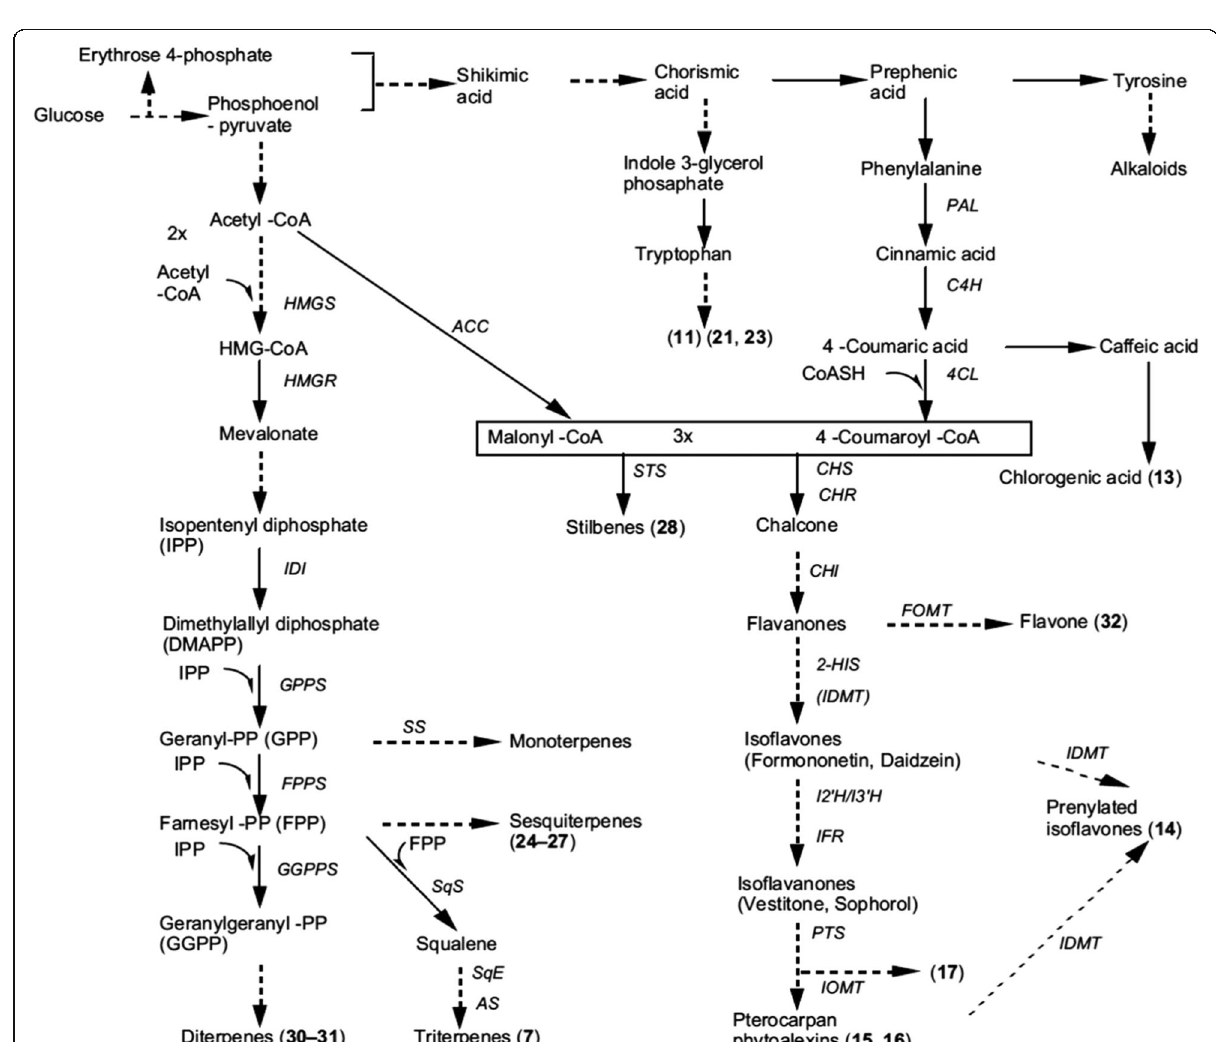
Fig. 1 Biosynthetic pathways of plant phytochemicals and their related enzymes. Source: